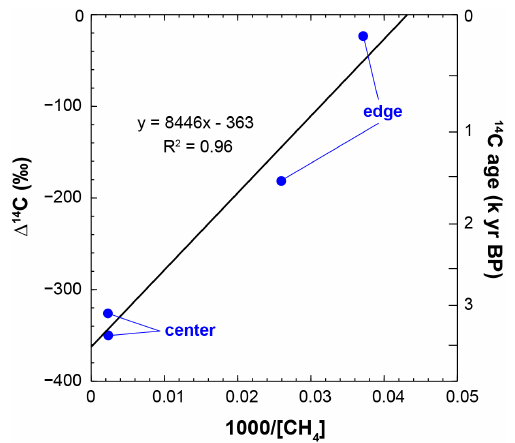
Figure D1. Keeling plot of lake ebullition CH 4 sampled in 2014, showing a mixing of millennium-old and highly concentrated gas with near-modern and less concentrated gas. Concentration ( x axis) is expressed as 1000/partial pressure (in ppmv, parts per million volumetric), whereas radiocarbon age is expressed as the normal- ized radiocarbon activity ( (cid:49) 14 C, in ‰; left y axis) and in thousands of years before present (kyr BP; right y